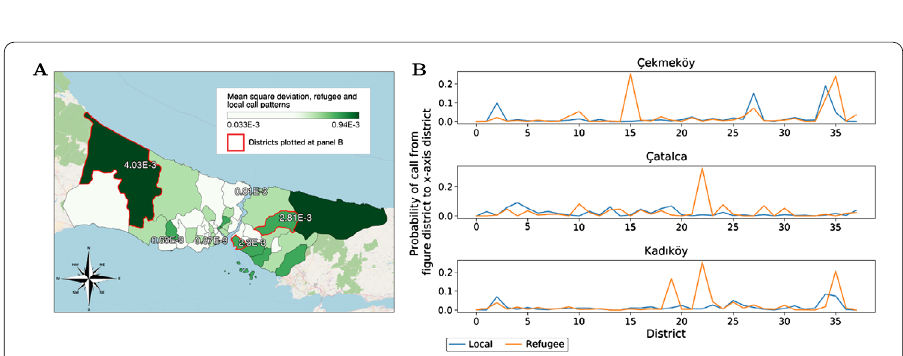
Figure 4 District level analysis of the difference between communication patterns of the Turkish and refugee populations. Panel A illustrates the mean squared deviation of the distribution of probabilities of communication (call and SMS) destination originating from each district (e.g., the chances that a call from district i will be directed at district j and not a third district k ). That is, for district i this is obtained